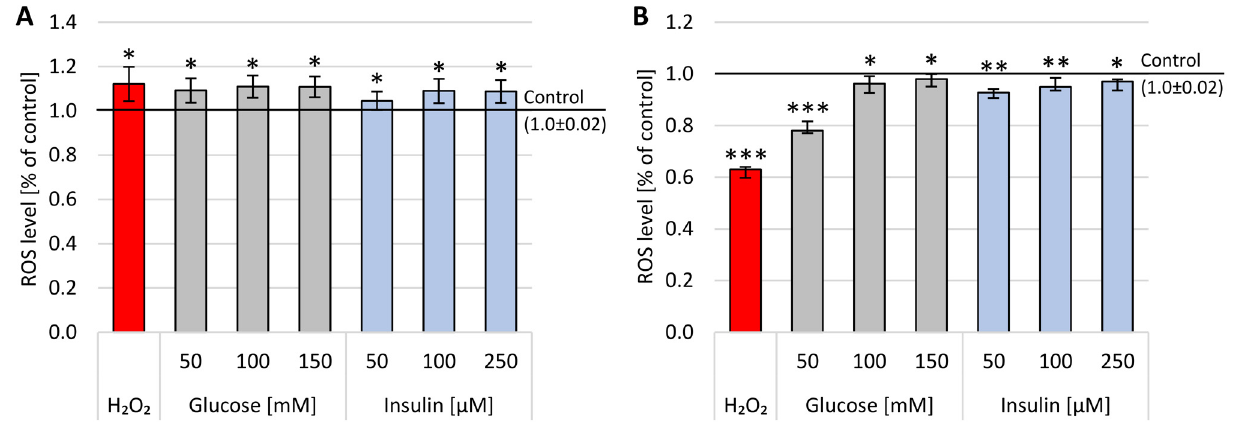
Figure 3. ROS levels in neuron-like cells after: ( A ) 1 h incubation with glucose or insulin and ( B ) 24 h incubation with glucose (50, 100 or 150 mM) or insulin (50, 100 or 150 µM). Control—untreated neuron-like cells; H 2 O 2 —cells incubated with 50 µM H 2 O 2 (positive control). Statistically significant differences compared to the untreated neuron-like cells: * p < 0.05, ** p < 0.01, *** p < 0.001.